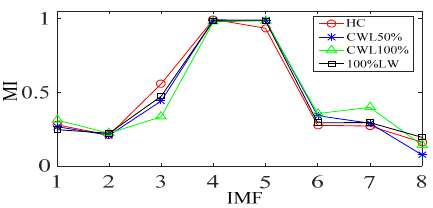
Figure 19. MI value curve corresponding to the IMF component in different states.